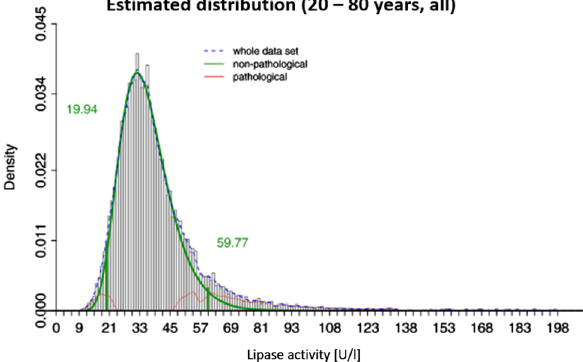
Figure 3: Estimated distribution for non-pathological values (green curve), pathological values (red) and whole data (blue). Green lines with given numbers indicate 2.5th and 97.5th percentile of the estimated distribution for non-pathological values (RL). (n=23.359, female and male, 20 – 80 years old).